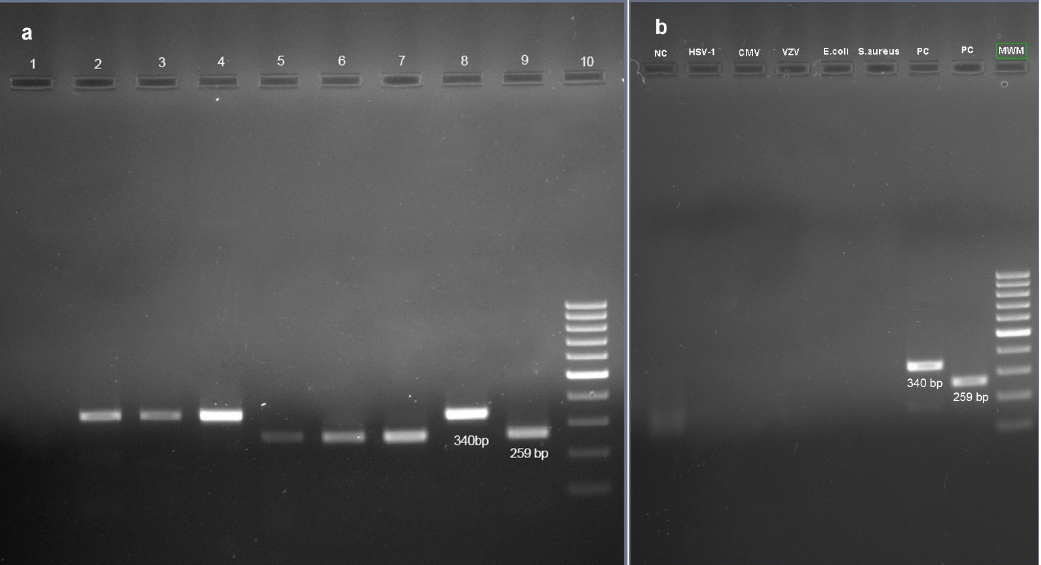
Figure 4. ( a ): Gel image showing a more intense band of 340 bp) amplicon size of mucorales and less intense band of 259 bp amplicon size of the non-mucorales; ( b ): Gel image showing the speci- ficity of PCR assay.